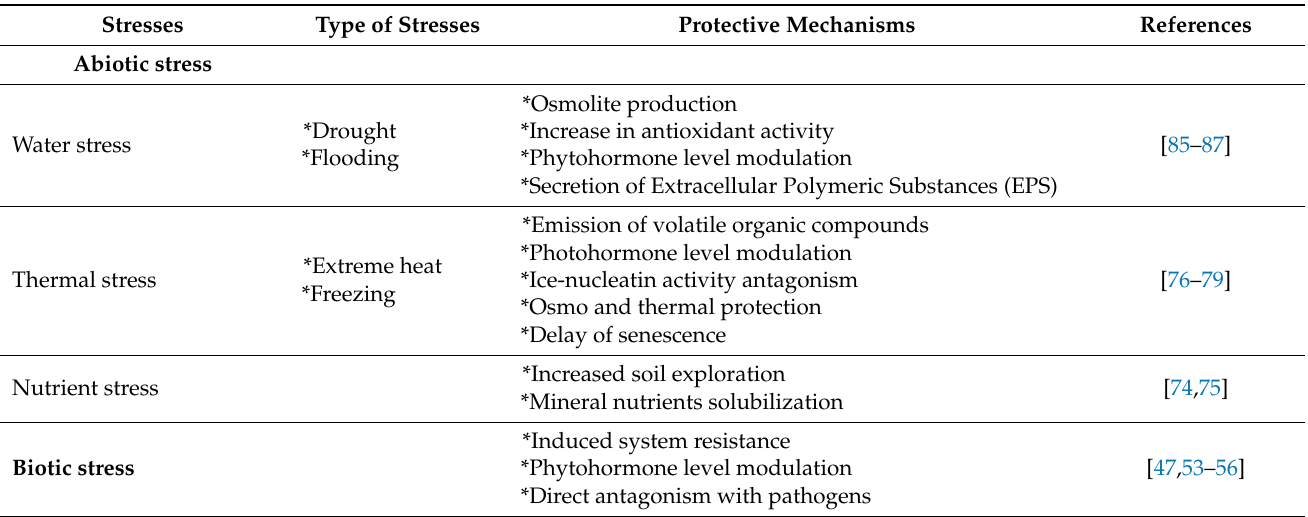
Table 1. The most important protective mechanisms related to the application of different microbial biostimulant in regards to both biotic and abiotic